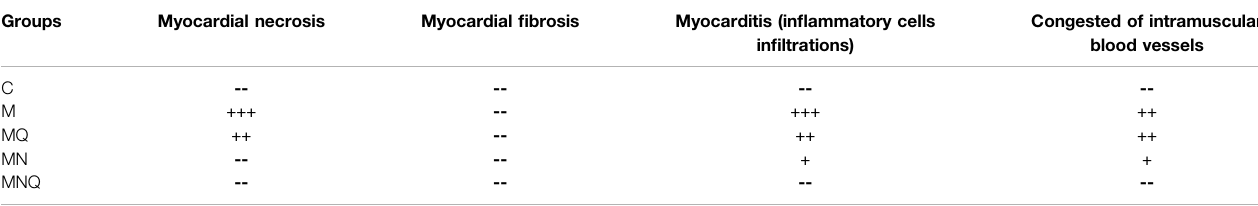
TABLE2| Scoringofhistopathological fi ndingsofheartsofcontrol(C),metabolicsyndrome(M),plainnano-pharmaceuticalformulation(MN),standardquercetinsuspension (MQ) and the quercetin loaded nano-pharmaceutical formulation (MNQ) groups.